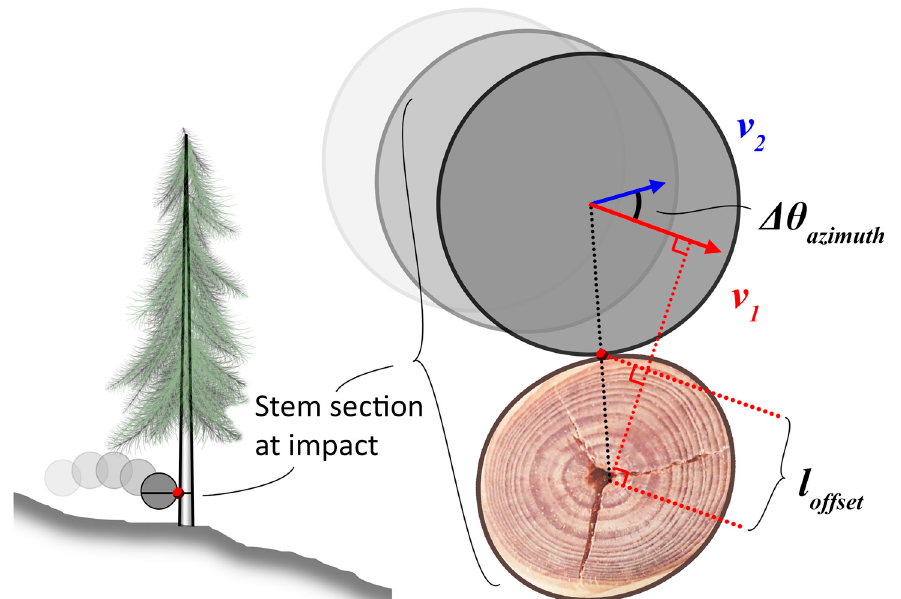
Figure 15. Parameters for the impact model against tree stems. The lateral offset is measured from the center of the stem to the contact point with the impacting rock, perpendicular to the initial velocity in the horizontal plane. Table 1. Probabilities for deviation occurring after an impact against a stem (after Dorren et al. [49]).